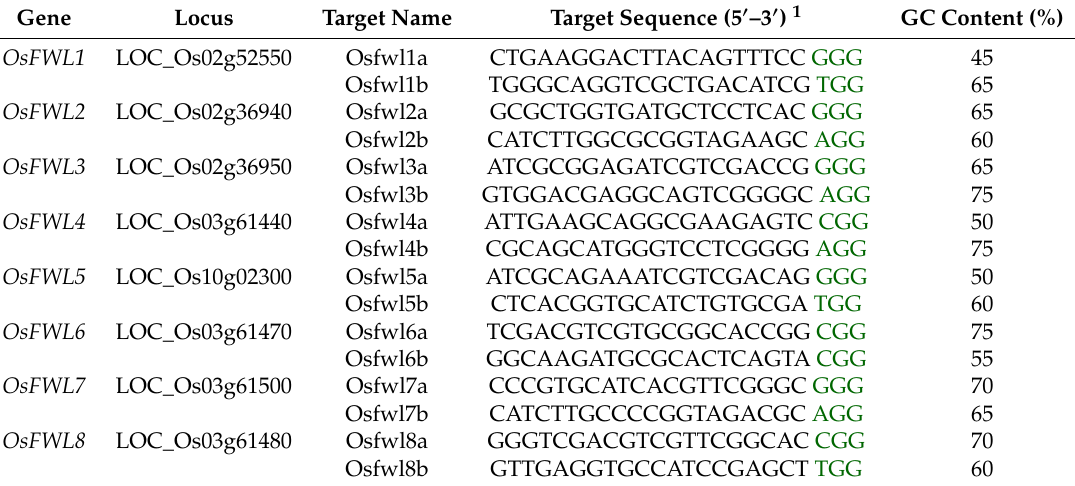
Table 1. Target sites of rice FWL genes for clustered regularly interspaced short palindromic repeats (CRISPR) / CRISPR-associated protein 9 (Cas9)-mediated gene editing.